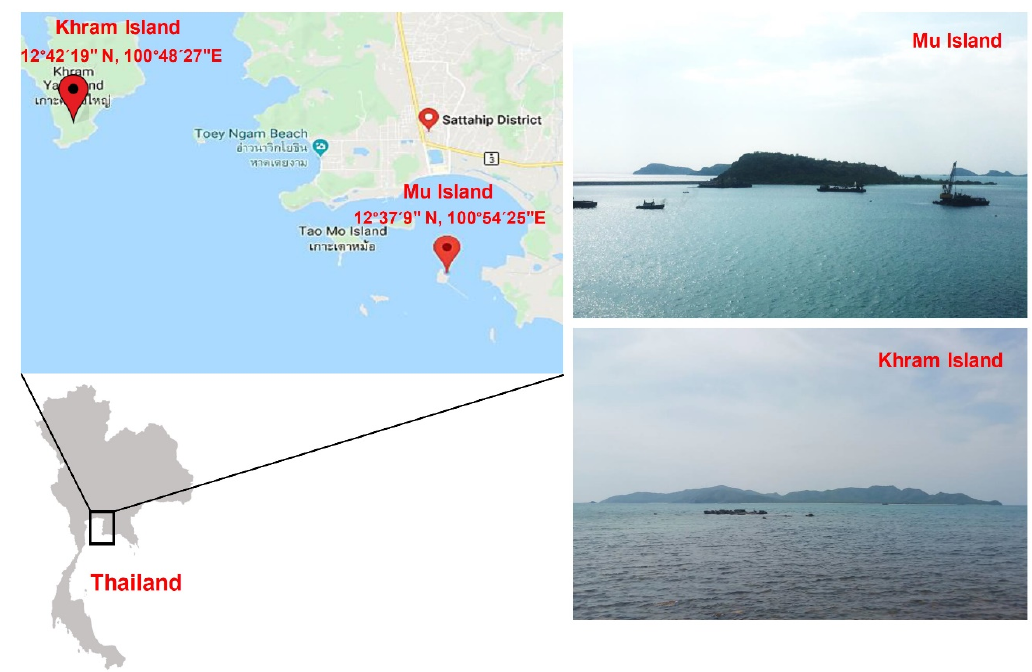
Figure 1. Map of Mu and Khram islands.